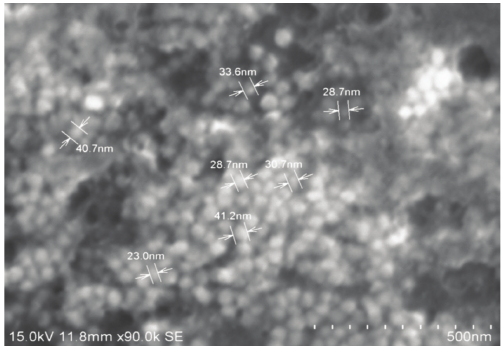
Figure 1: Photomicrograph showing spherical shape of silver nanoparticles using field scanning electron microscope.